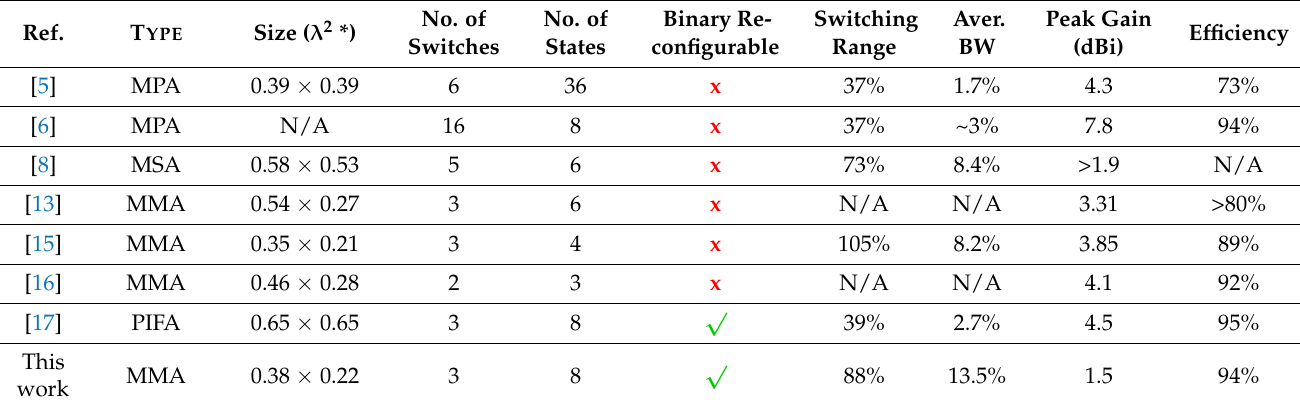
Table 3. Comparisons between several recently proposed FRAs.